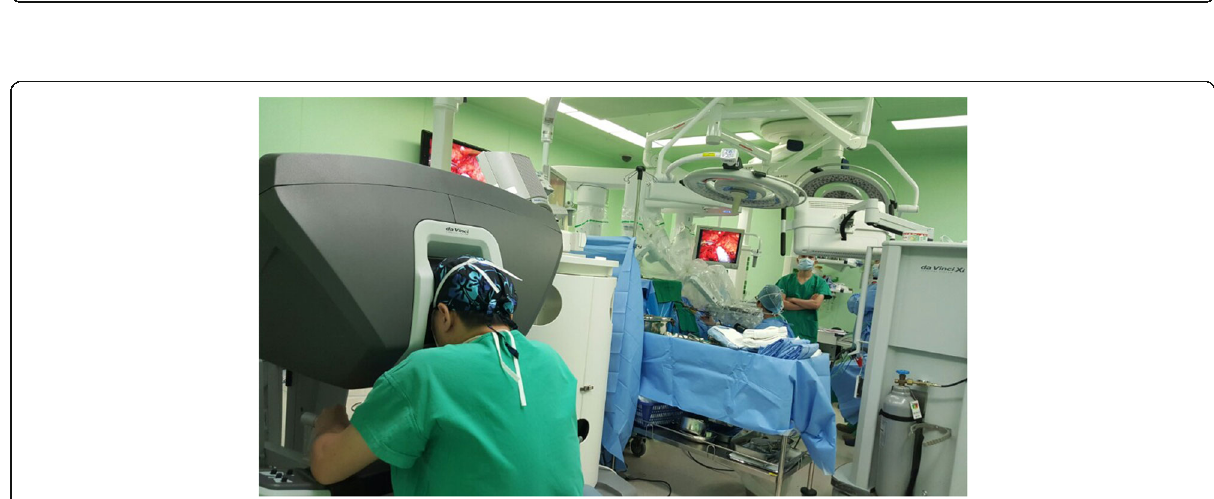
Fig. 4 Dissection using the da Vinci Xi surgical system (Intuitive Surgical Inc., CA, USA) with two endowrist arms (monopolar curved scissors and Maryland bipolar forceps) ( left ) and excised specimen ( right